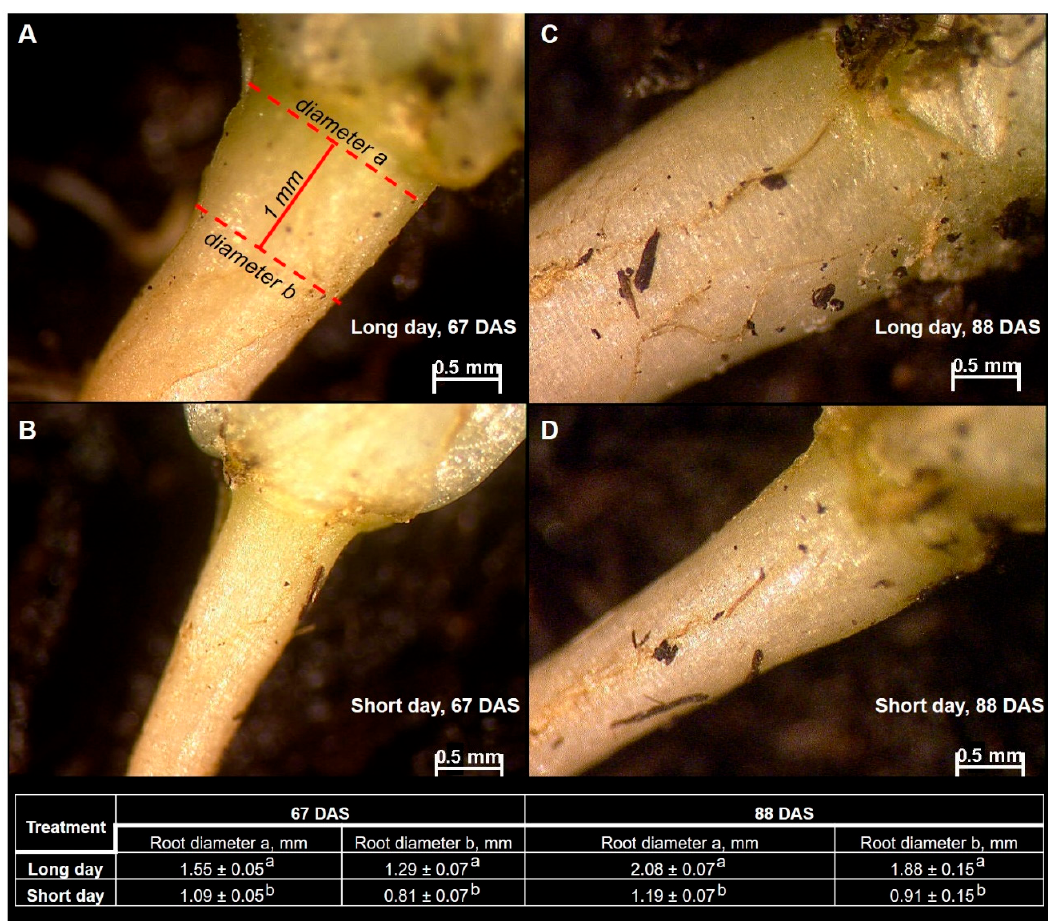
Figure 4. Images of the hypocotyl and hypocotyl diameter (mm) of yellow maca plants grown in rhizoboxes under controlled conditions at long-day (16 h) ( A , C ) or short-day (8 h) ( B , D ) conditions (2.5× magnification). The measurements were performed in two positions: diameter a and diameter b ( A ), at 67 DAS and after harvest (88 DAS). Results represent mean values ± SEM of three independent replicates. Different letters indicate significant differences between treatments ( p ≤ 0.05).